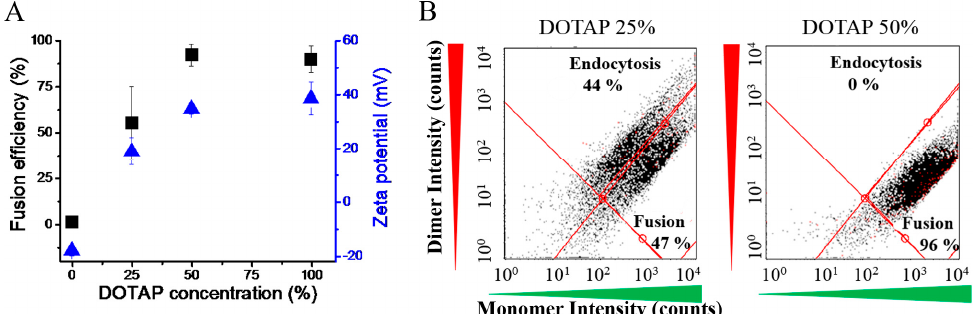
Figure 2. ( A ) Liposomal zeta potential (blue triangles) and fusion efficiency (black squares) at varying cationic lipid concentration. Bar indicate standard deviations. ( B ) Flow cytometry dot plots to determine the cellular uptake pathway and its efficiency. Liposomes always contained the aromatic tracer BODIPY FL-DHPE. Its monomer signal was detected in the green, its dimer signal in the red channels after incubation with Chinese hamster ovary cells (CHO). Endocytotic liposomal uptake resulted in a nearly equal dimer and monomer signals of the tracer, while a high monomer and a low dimer signal were detected in the case of membrane fusion.